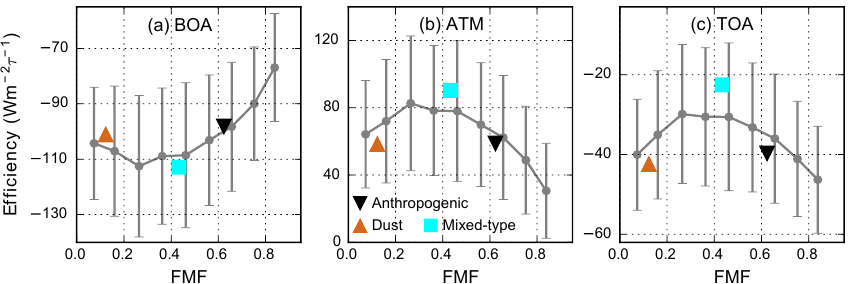
Figure 10. Direct aerosol radiative efficiency as a function of FMF in the East Asian region: (a) BOA, (b) ATM, and (c) TOA. The average radiative efficiencies of the dust, mixed-type, and anthropogenic aerosols are also plotted.